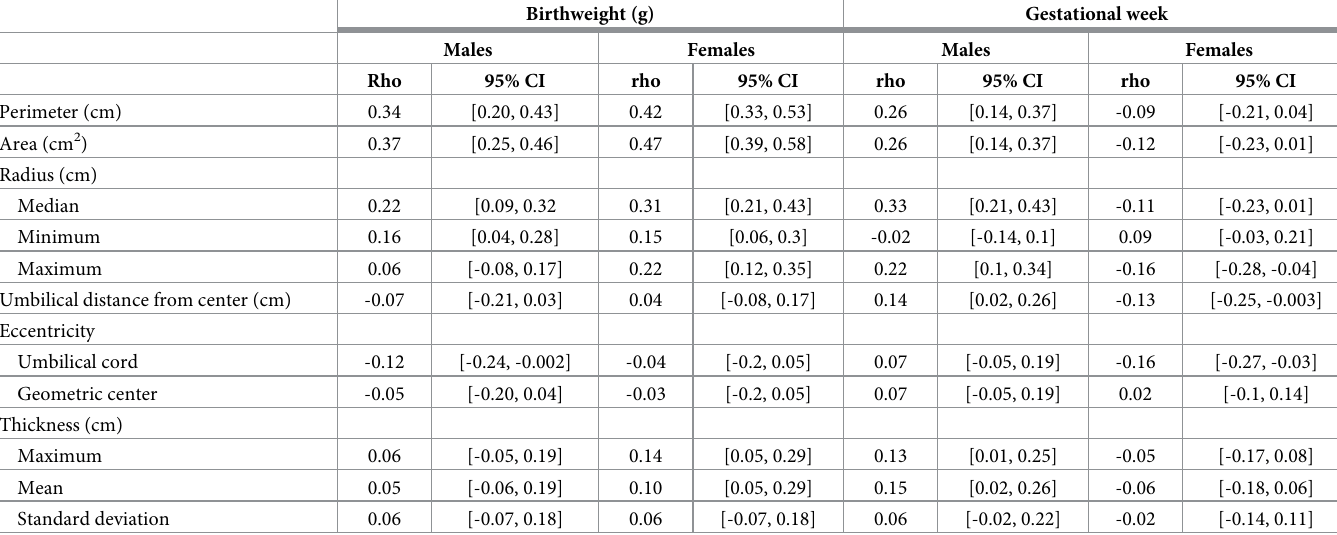
Table 3. Spearman’s correlation (rho) between birthweight, gestational week and placental morphology by child sex.